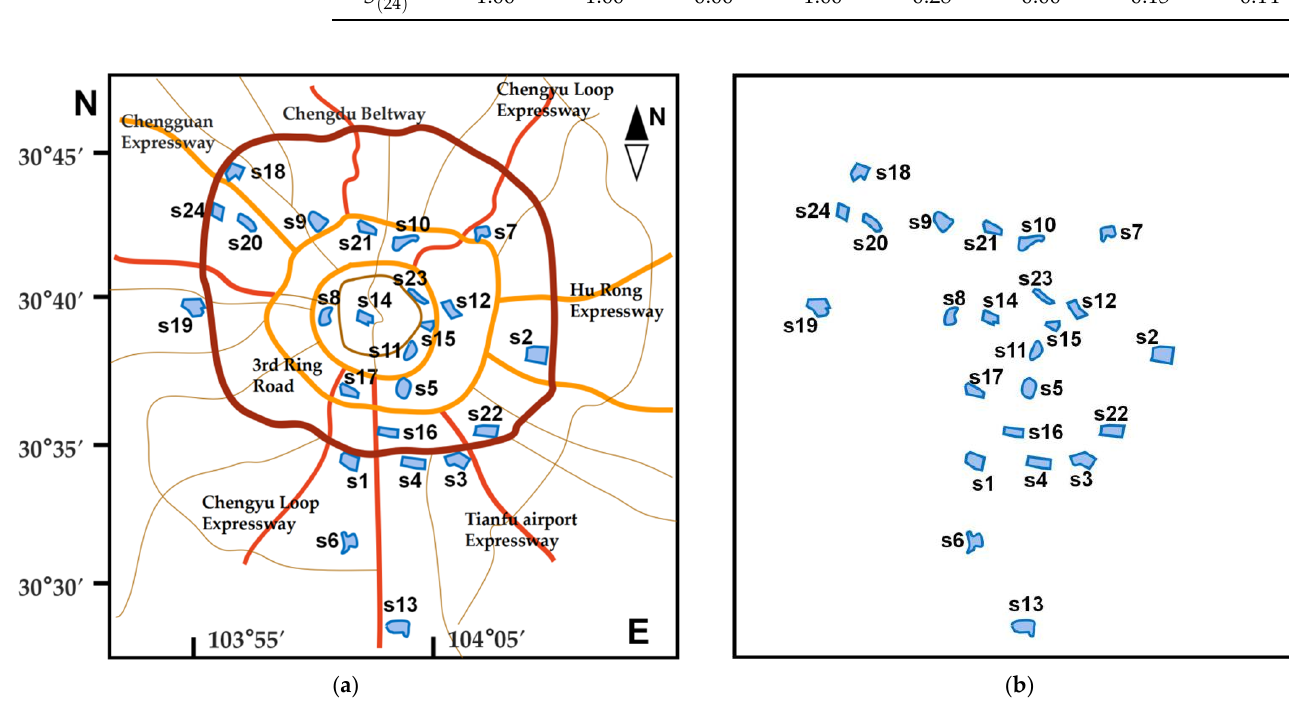
Figure 4. The sample scenic water spots’ distribution map and the scenic water spot initial cluster . ( a ) Map of the Chengdu sample scenic water spots. ( b ) Scenic water spot initial cluster for the improved DIANA